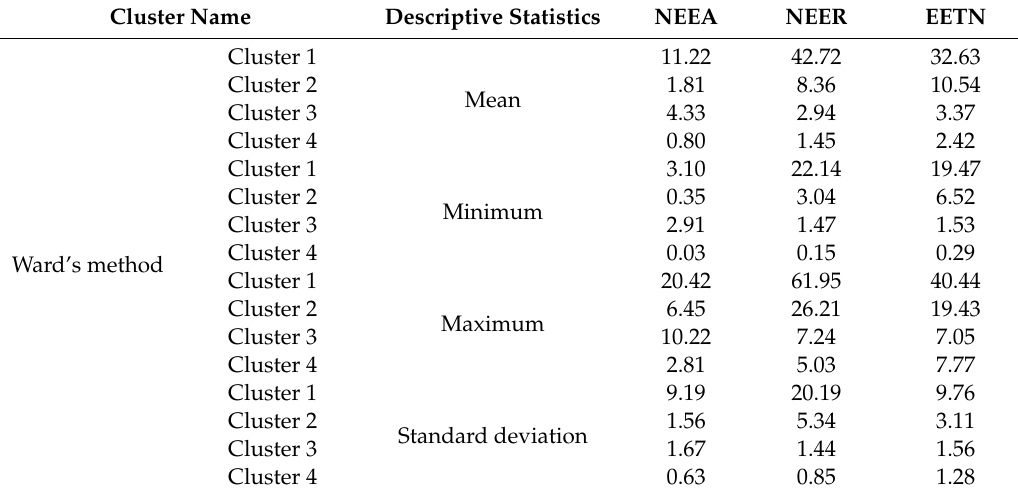
Figure 2. Commune grouping based on the cluster analysis. Source: this research. Table 5. Descriptive characteristics of the clusters.